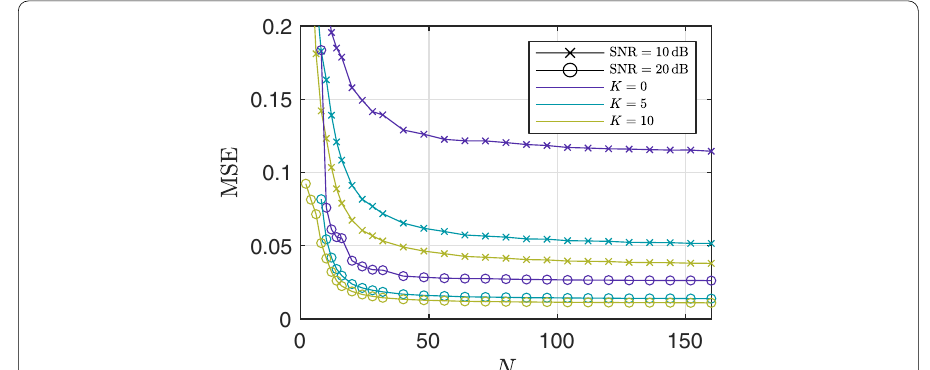
Fig. 10 Influence of the LOS estimation history length N on the MSE of the prediction. F = 10dB , (cid:31) tf m = 0.05 and M =